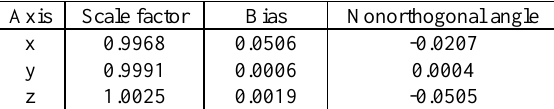
Table 1. Calibrated parameters of the accelerometer triad